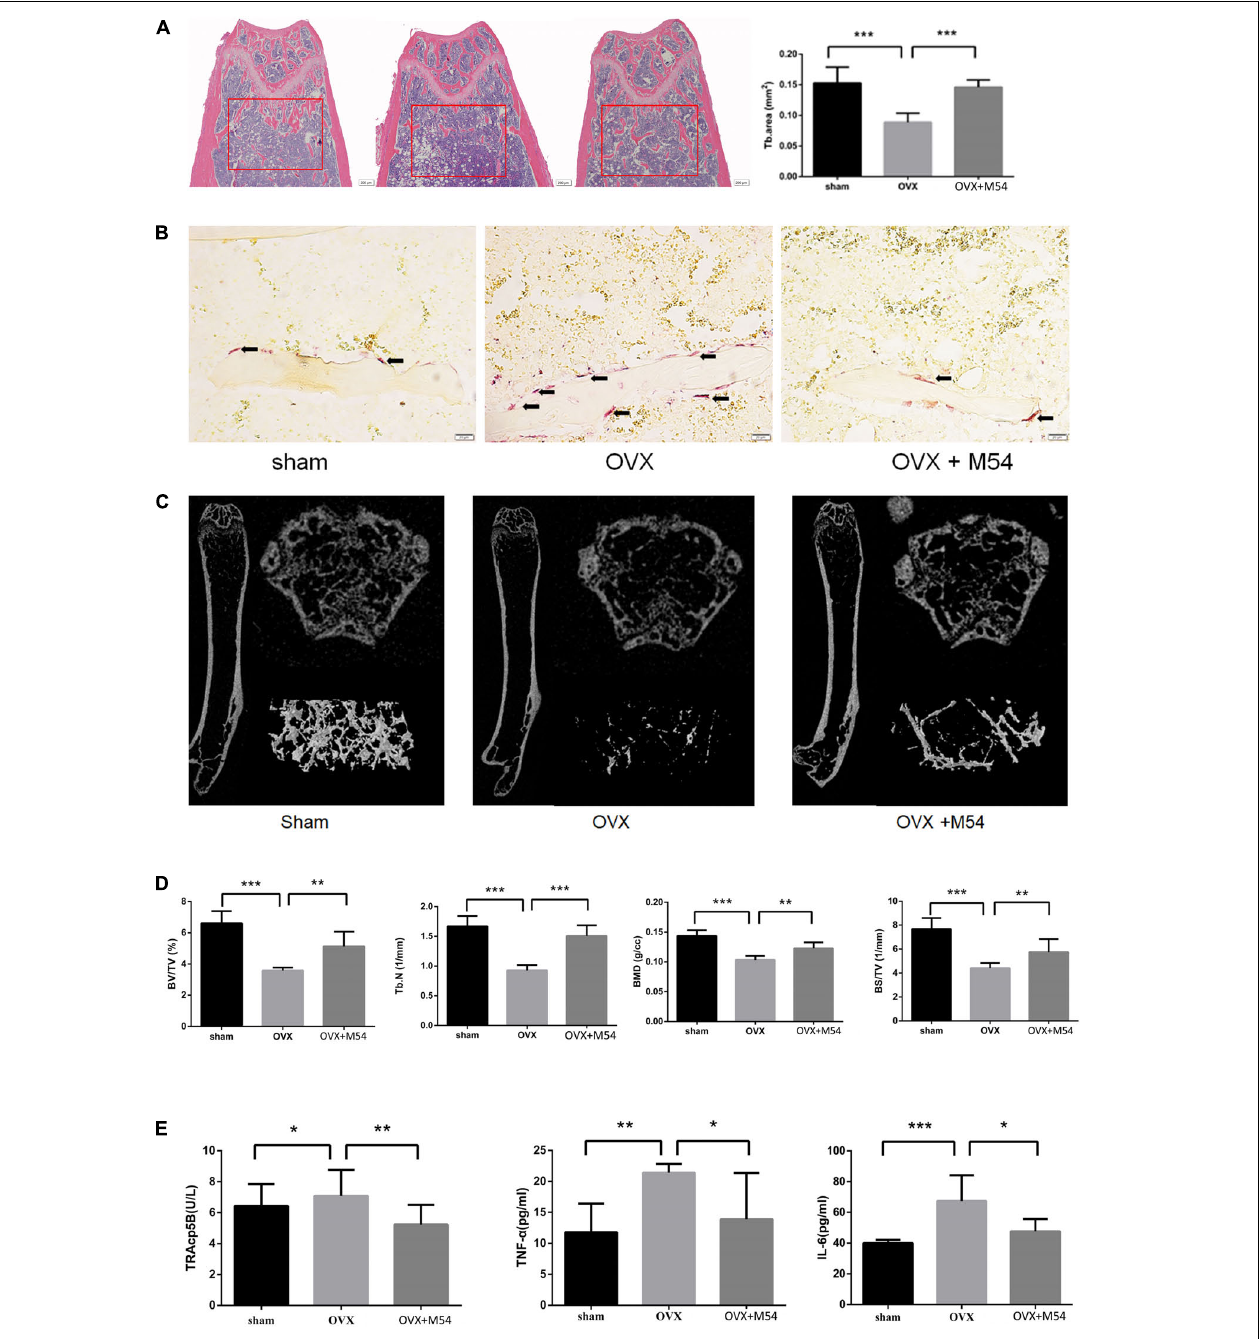
FIGURE 6 | M54 prevents ovariectomy-induced bone loss in vivo . (A) Representative H&E staining of distal femoral sections and quantification of trabecular area from each group 6 week after the operation ( × 40). (B) Representative TRAP-stained histologic distal femur sections from sham, OVX and OVX + M54 group ( × 400). (C) Micro CT analysis of the distal femur from sham, OVX, and OVX + M54 group. (D) Calculations of bone value/total value (BV/TV), trabecular number (Tb.N), bone mineral density (BMD), and bone surface area/total value (BS/TV). (E) Serum TRAcp5B, TNF- α , and IL-6 were examined ( ∗ P < 0.05, ∗∗ P < 0.01, ∗∗∗ P < 0.001).